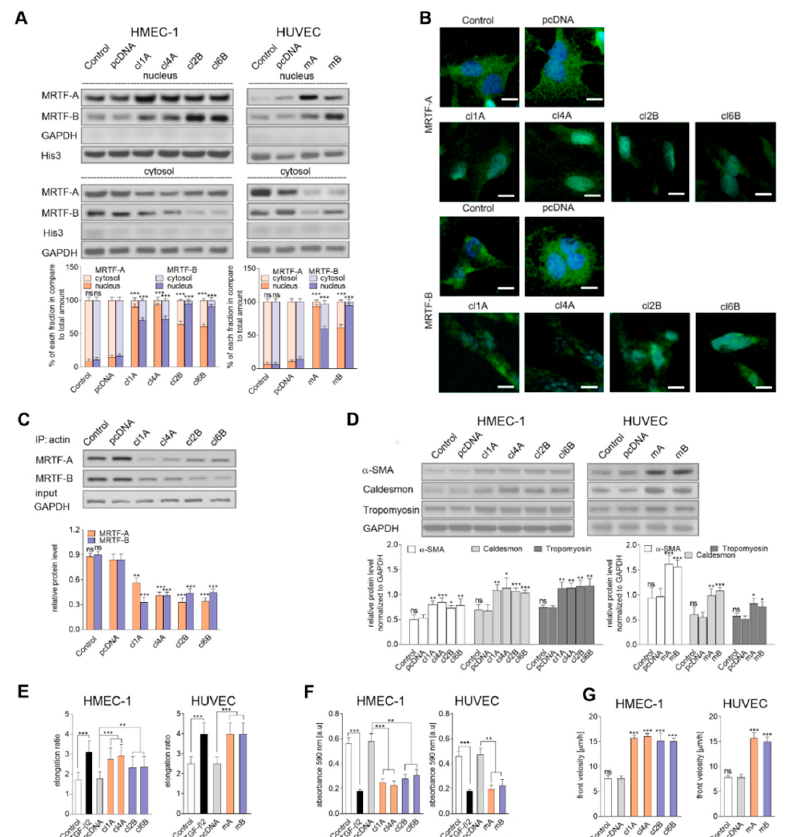
Figure 4. MRTF overexpression resulted in their activation, nuclear accumulation, and induction contraction and adhesion ability. ( A ) MRTF-A and MRTF-B localization were analyzed by Western blotting of the cytosol and nucleus fractions isolated from transfected cells. ( B ) The localization of MRTF-A and MRTF-B in the cellular compartments were analyzed using a confocal microscope. MRTFs were stained with antibodies conjugated with FITC. The white bar represents a 30 μ m length. Representative images are shown. ( C ) Additionally, an IP assay of the cytosol fraction protein was applied. The MRTFs that interacted with the actin was precipitated with mouse anti-actin protein and subsequently analyzed by a Western blot assay with anti-rabbit MRTF-A or MRTF-B antibodies. ( D ) Contraction markers, such as α -SMA, caldesmon, and tropomyosin, were determined by Western blot analysis. For ( A – D ), the protein level in each sample was determined using scan densitometry. The results were normalized to GAPDH (cytosol and a nuclear fraction or total lysates) or Histone3 (His3, cytosol and nucleus fraction), or total the MRTFs (IP assay). Blots are representative of three independent experiments. The results are presented as the means ± SD ( N = 3); * p < 0.05, ** p < 0.01, *** p < 0.001. ( E ) Changing in the cell morphology was observed under the microscope. Representative images are shown in the supplementary data (Figure S5) and a quantitative analysis of mean of the elongation ratio (( N = 3); ** p < 0.01, *** p < 0.001) was performed in Meta®Morph. Bars, 30 μ m. ( F ) Subsequently, adhesion properties to collagen I was analyzed. Cells were placed on the collagen I pre-coated well for 1 h to adhere. After washing, the cells were stained, and the total cell-associated protein was determined using a microplate reader at 595 nm. The results are presented as the means ± SD ( N = 5); ** p < 0.01, *** p < 0.001. ( G ) The e ff ect of MRTF-A- or MRTF-B-overexpression on cell movement by the wound healing assay was studied. An appropriate cell number was seeded on 12-well plates pre-coated with collagen 1 (Coll). A total of 48 h later (after 4 h starvation in an FBS-free medium), a monolayer of confluent cells was wounded and images thereof were captured at the following times: 0, 2, 4, 6, 8, 10, 12, and 24 h. The results are given as the standard error of the mean of the cell front velocity ± SD ( N = 4); *** p < 0.001.